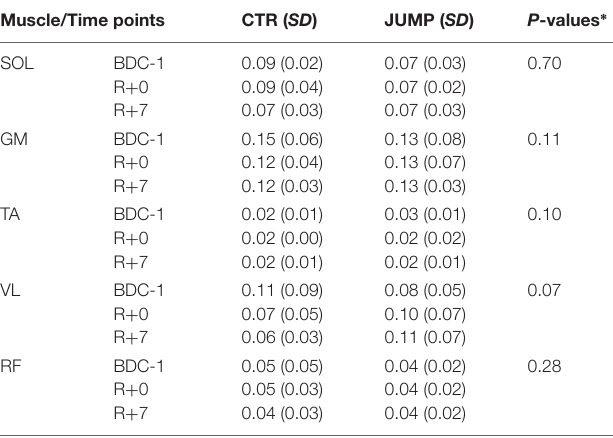
TABLE 2 | Muscle physiology data from RSL study groups before and after bed rest. Muscle/Time points CTR ( SD ) JUMP ( SD ) P -values ∗